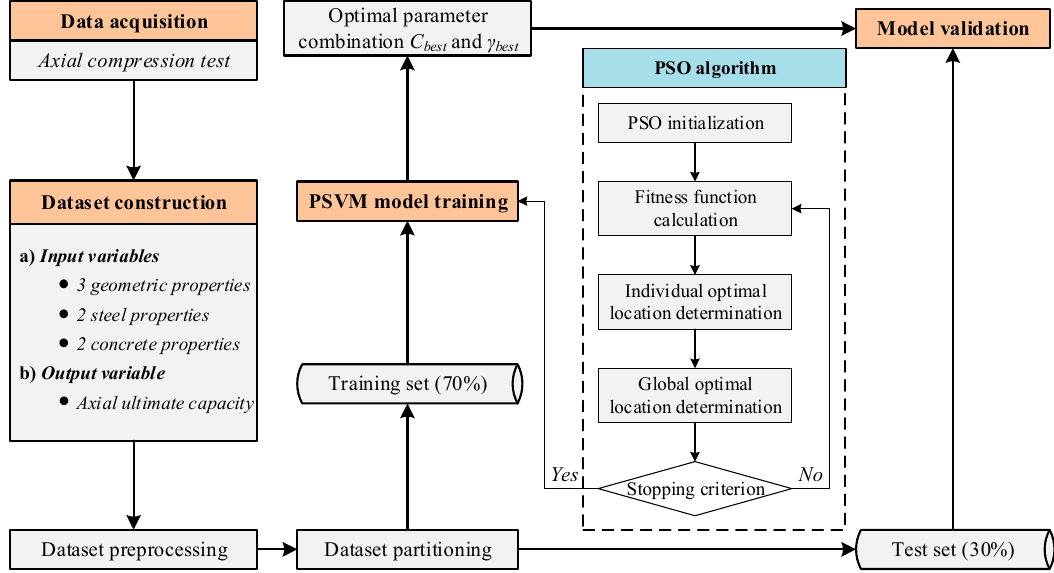
Figure 2. Architecture description of the proposed PSVM model.